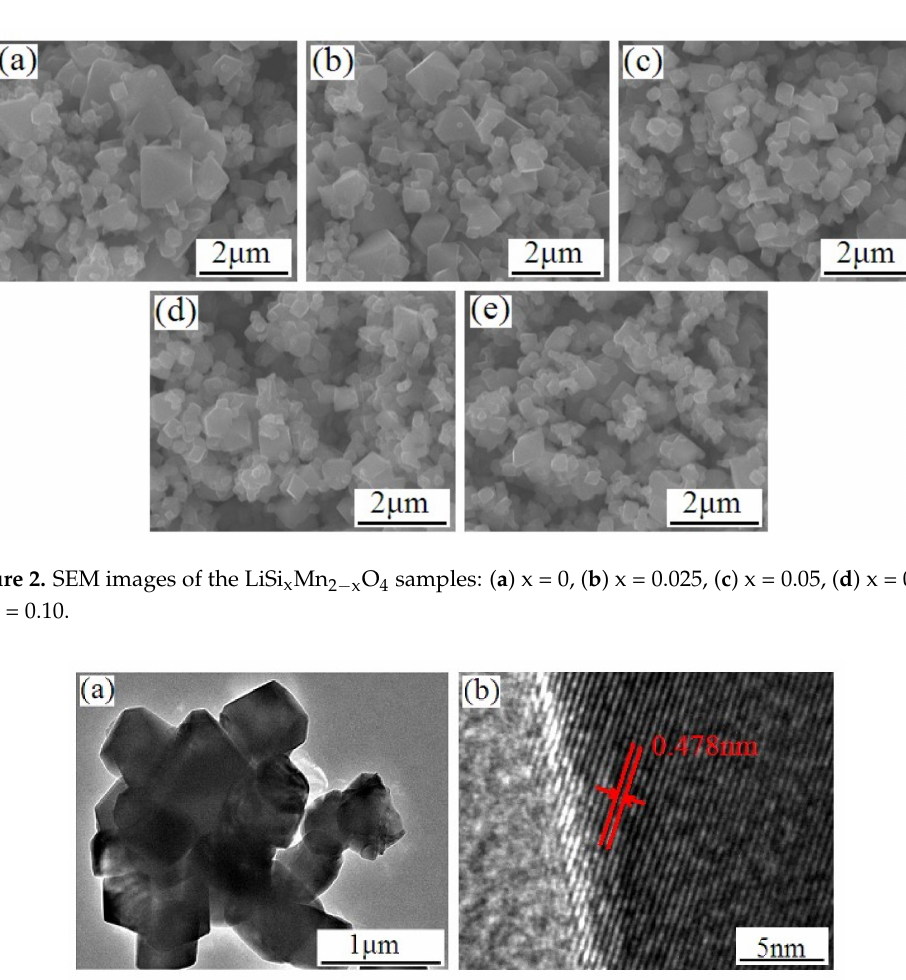
Figure 3. ( a ) TEM image and ( b ) HRTEM image of the LiSi 0.05 Mn 1.95 O 4